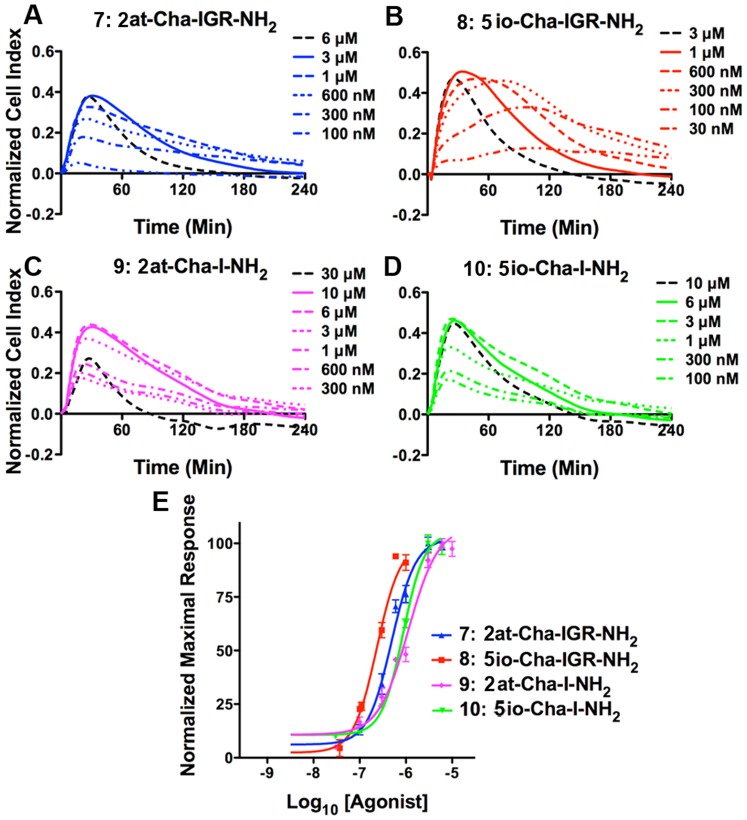

In vitro physiological responses of 16HBE14o- cells following addition of agonist compounds 7–10.Each of the top four panels (A–D) represents physiological response to agonist compounds as described for
Figure 2
. Concentrations for each experiment (at right of plots) show concentration responses that include supramaximal (black dashed lines) and maximal (solid line) responses. Compound 7: 2at-Cha-IGR-NH2, compound 8: 5io-Cha-IGR-NH2, compound 9: 2at-Cha-I-NH2, and compound 10: 5io-Cha-I-NH2 all display rapid RTCA responses. However, compounds 7, 9, and 10, all exhibit reduced peak Normalized Cell Index responses. Concentration response curves developed from RTCA using the peak response within the 4 hr experiment are shown in the bottom panel. Compounds 7–10 display activity consistent with previously described heterocycle-pentapeptides PAR2 agonists [19], [28]. EC50s for each compound are shown in
Figure 3
.